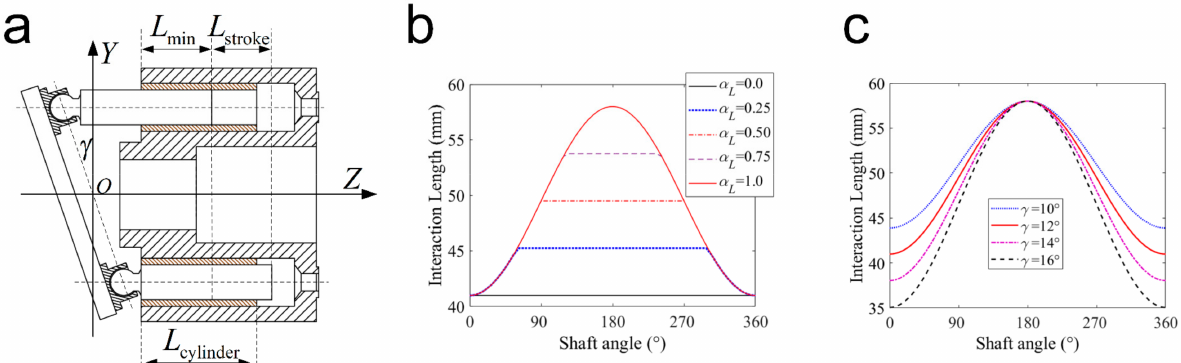
Figure 13. ( a ) The schematic of a swash-plate pump with different cylinder lengths and tilt angles, ( b ) the length of the lubrication interface with different cylinder lengths, and ( c ) the length of the lubrication interface with different tilt angles of the swash